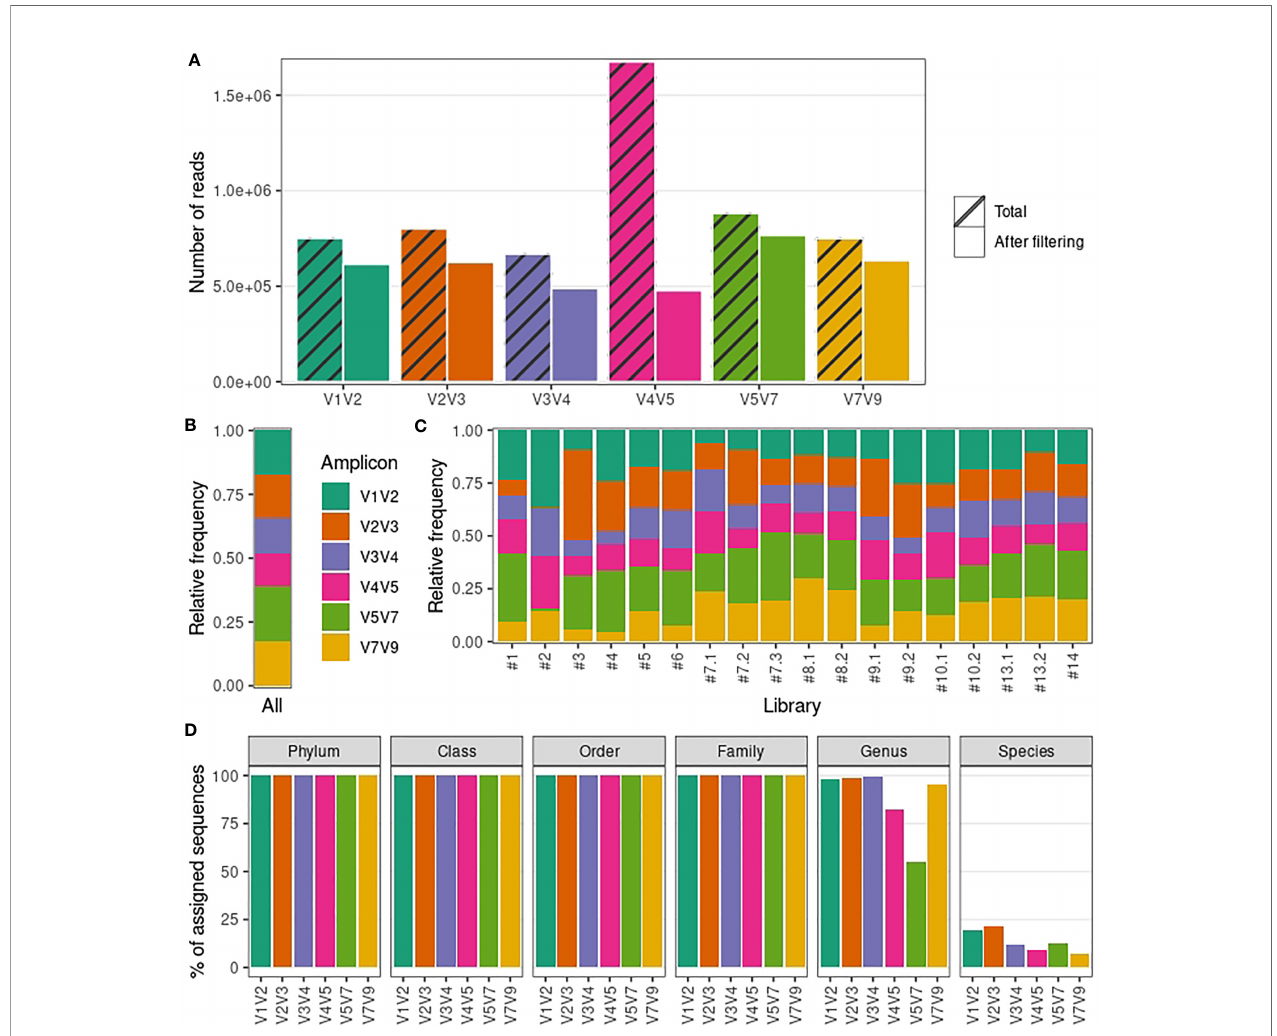
FIGURE 1 | Sequencing output and taxonomic resolution for each 16S rRNA amplicon-speci fi c dataset. (A) Number of reads generated and retained after fi ltering steps for each amplicon-speci fi c dataset. (B) Relative frequency of reads retained after fi ltering steps averaged over all libraries for each amplicon-speci fi c dataset. (C) Relative frequency of reads retained after fi ltering steps per library for each amplicon-speci fi c dataset. (D) Percentage of sequences with assigned taxonomy (per taxonomic level) for each amplicon-speci fi c